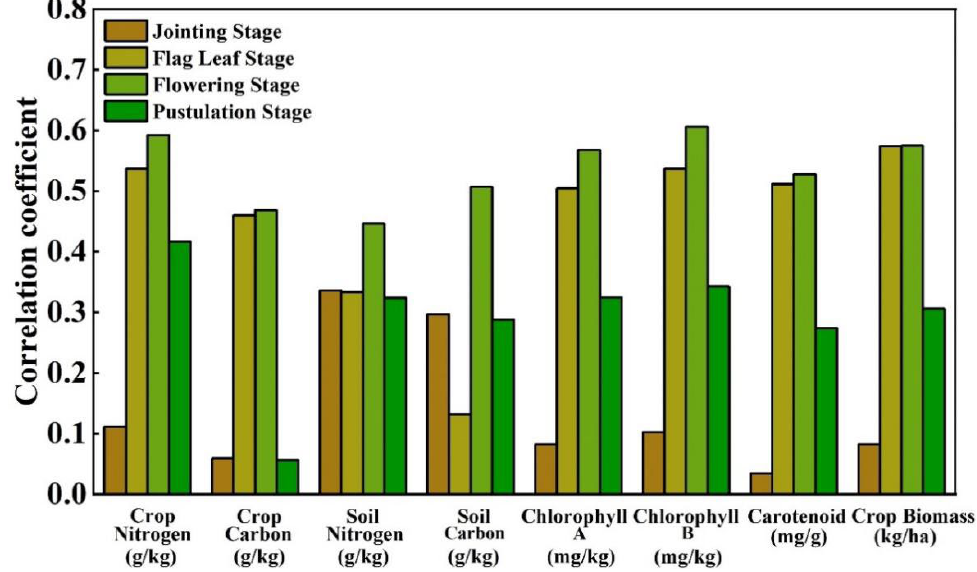
Figure 7. The correlation between other biochemical parameters and F P .